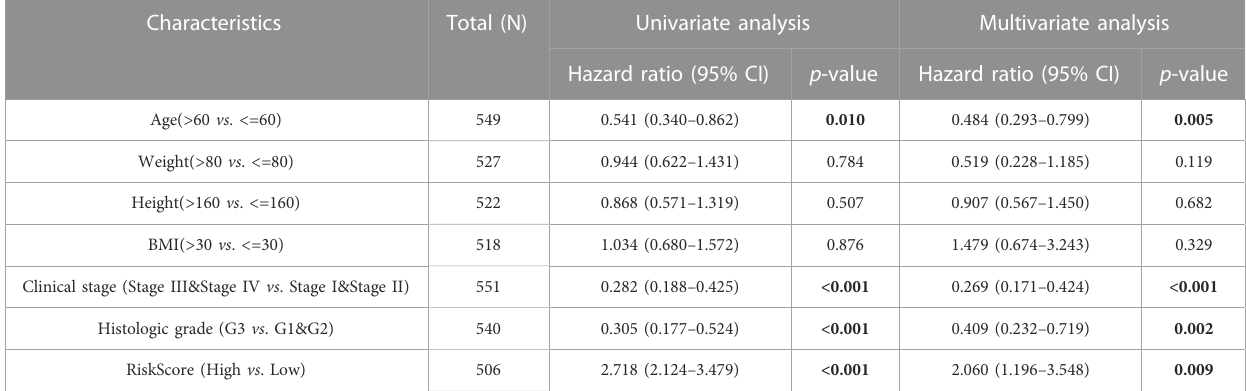
TABLE 4 Univariate and multivariate Cox regression analysis of clinicopathological characteristics of TCGA-UCEC.